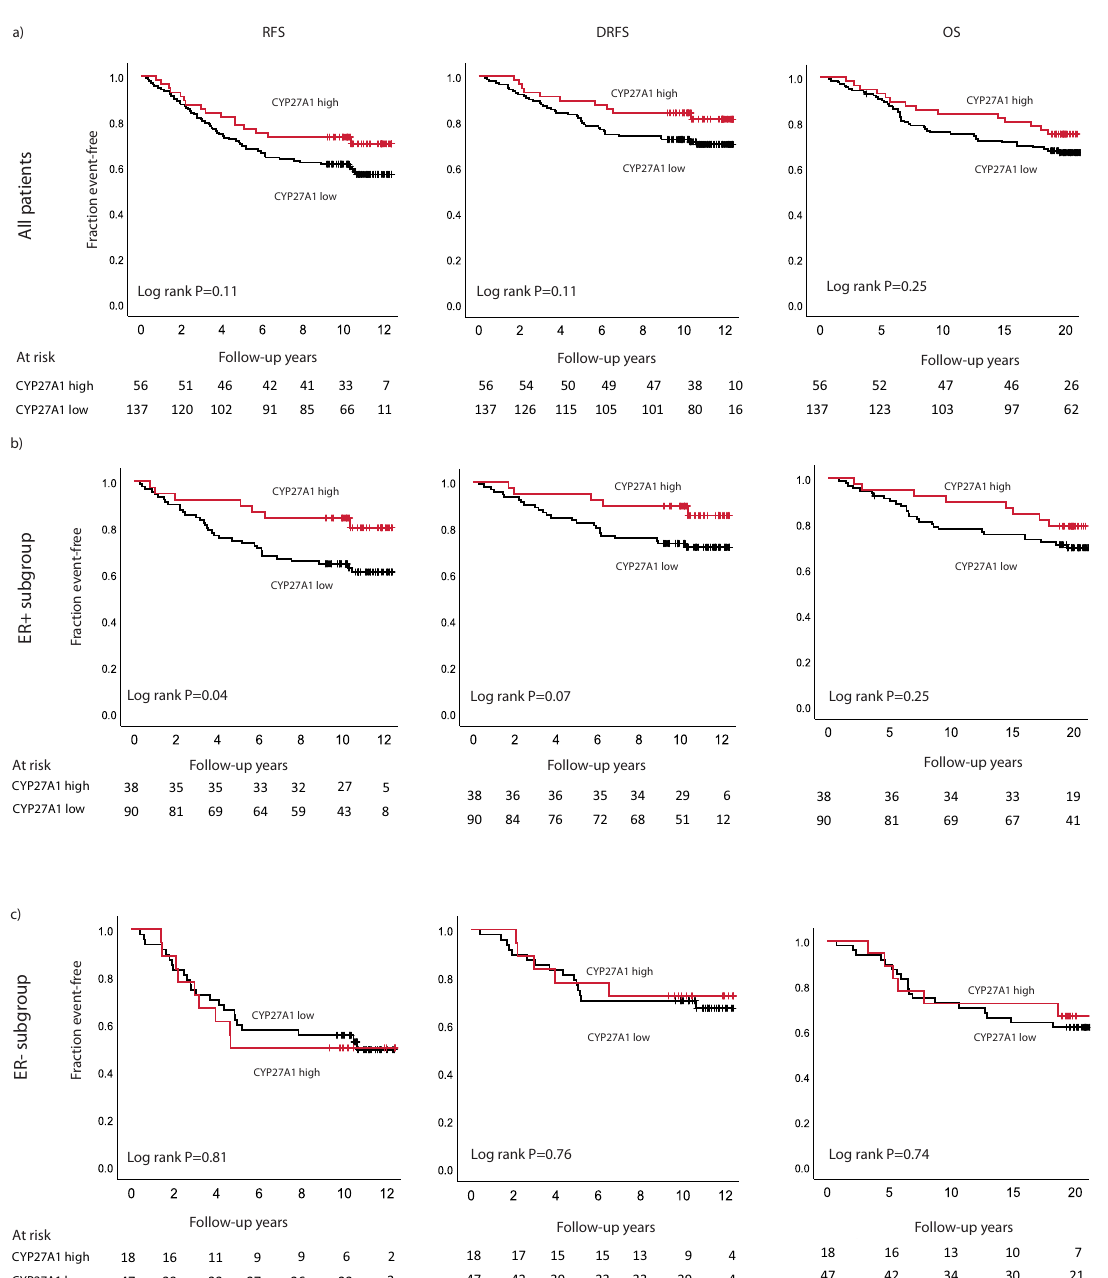
Fig. 1 Kaplan – Meier graphs showing associations between CYP27A1 protein expression and survival. a All patients, b patients with ER + tumors, and c patients with ER – tumors.